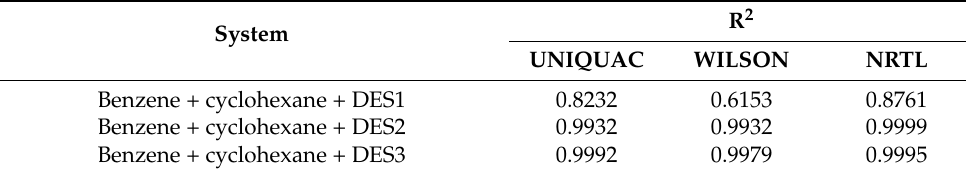
Table 3. Related index R 2 of three thermodynamic model fitting with cyclohexane-benzene—DES system.